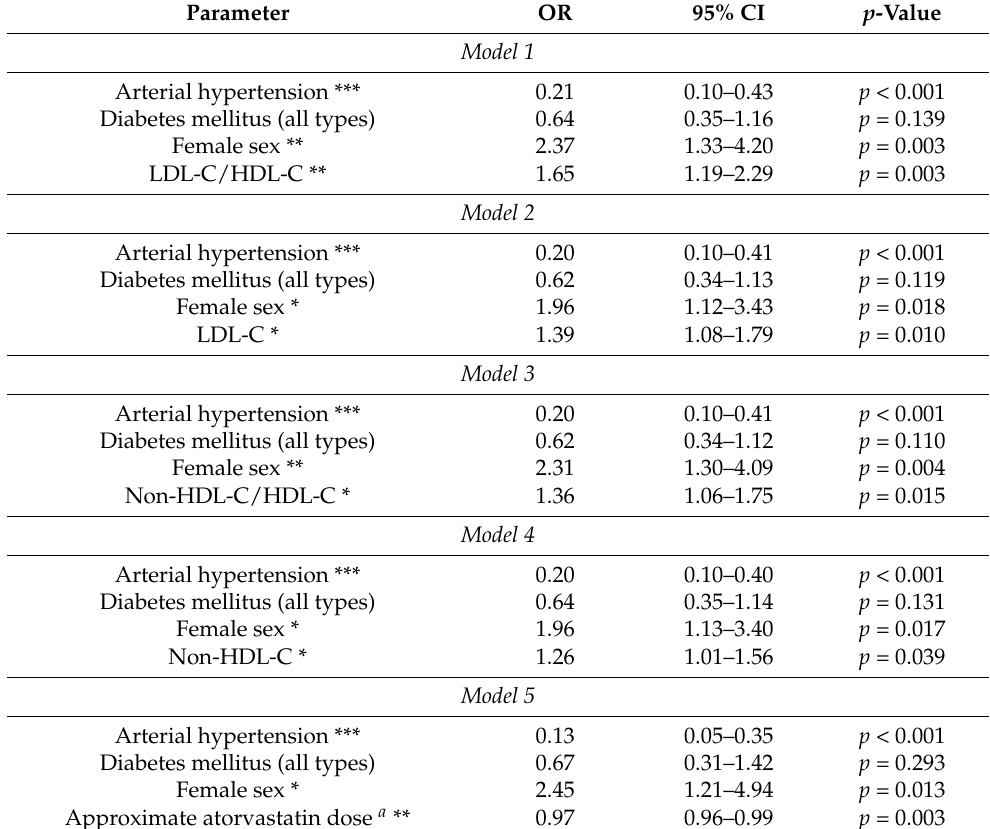
Table 3. Multivariable logistic regression